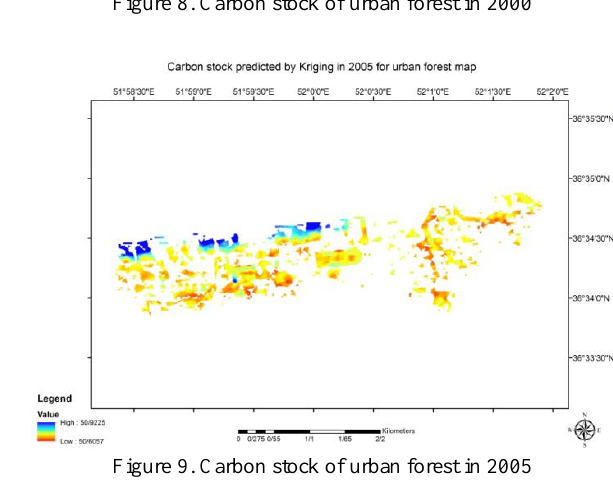
Table 3. The amount of Carbon stock